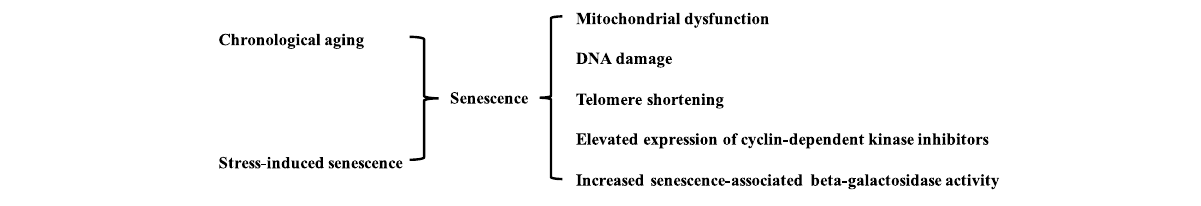
FIGURE 1 Characteristics of senescent blood vessels. Vascular senescence is induced by various stimulus and biological aging. The senescence in blood vesselsischaracterizedbymitochondrialdysfunction,DNAdamage,telomereshortening,elevatedexpressionofcyclin-dependentkinaseinhibitors,and increased senescence-associated beta-galactosidase activity.